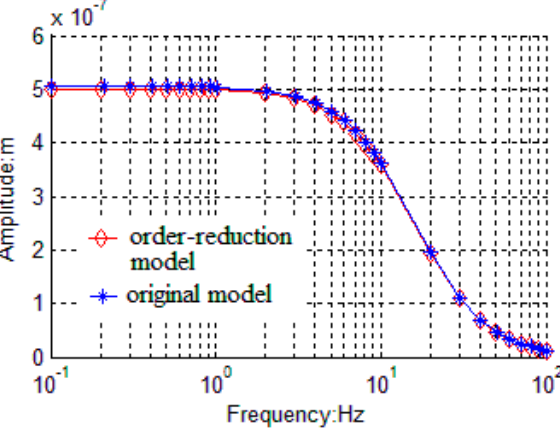
Figure 9. Frequency response characteristics of AGC loop based on the linearized model and the original model.